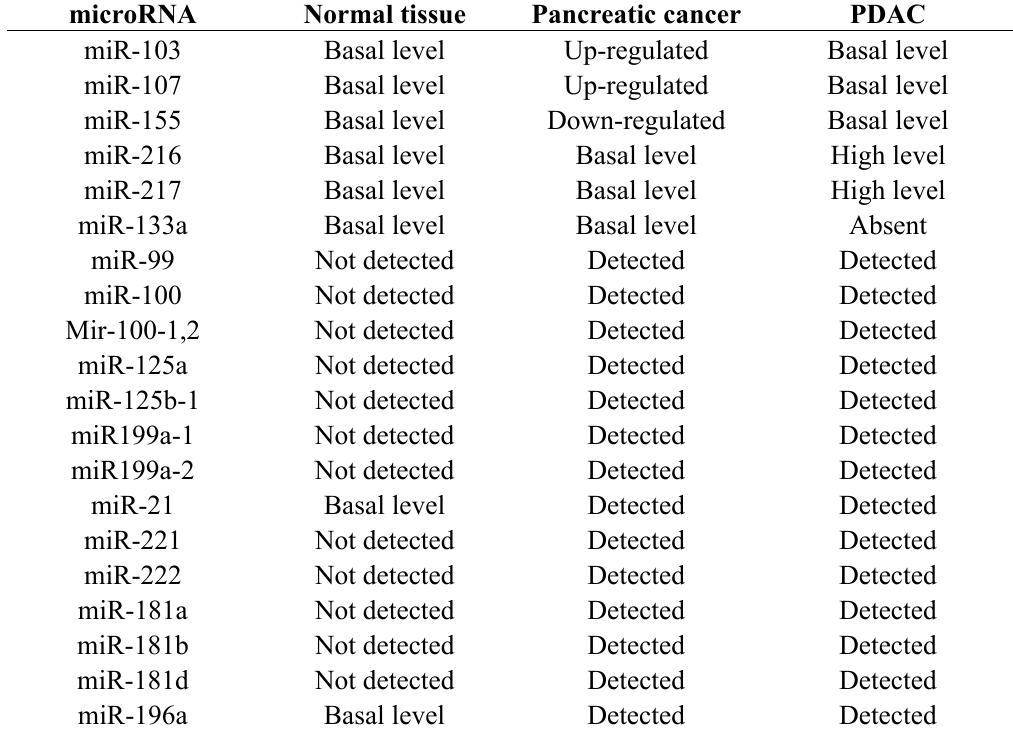
Table 4. Panel of microRNAs in normal and pancreatic